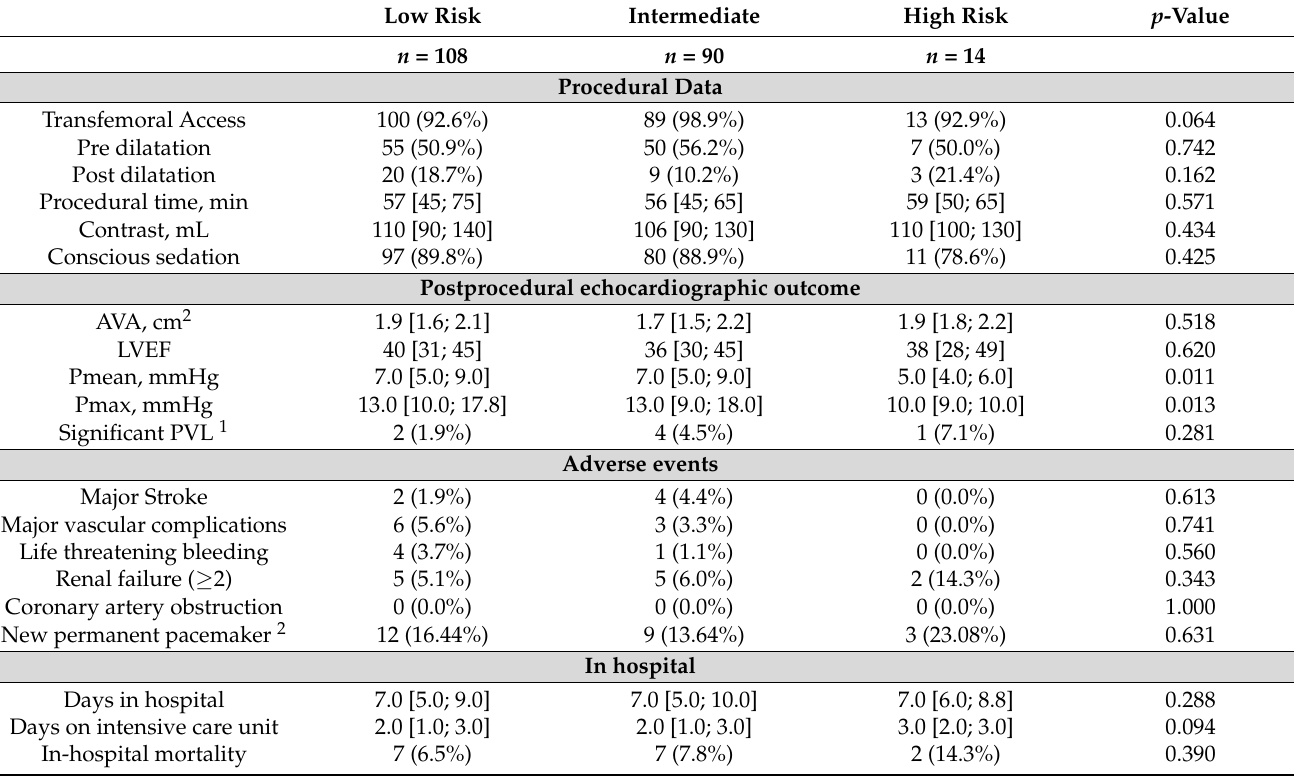
Table 3. Periprocedural